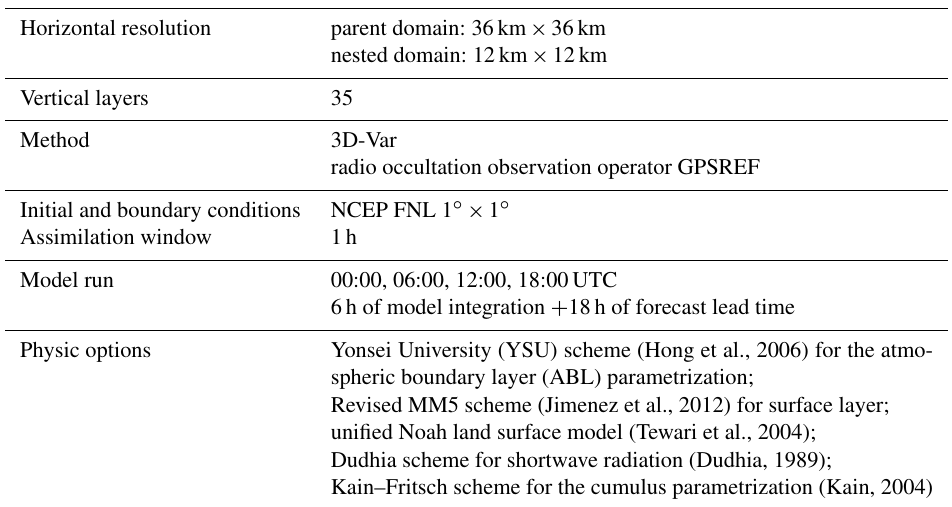
Table 2. Applied data assimilation